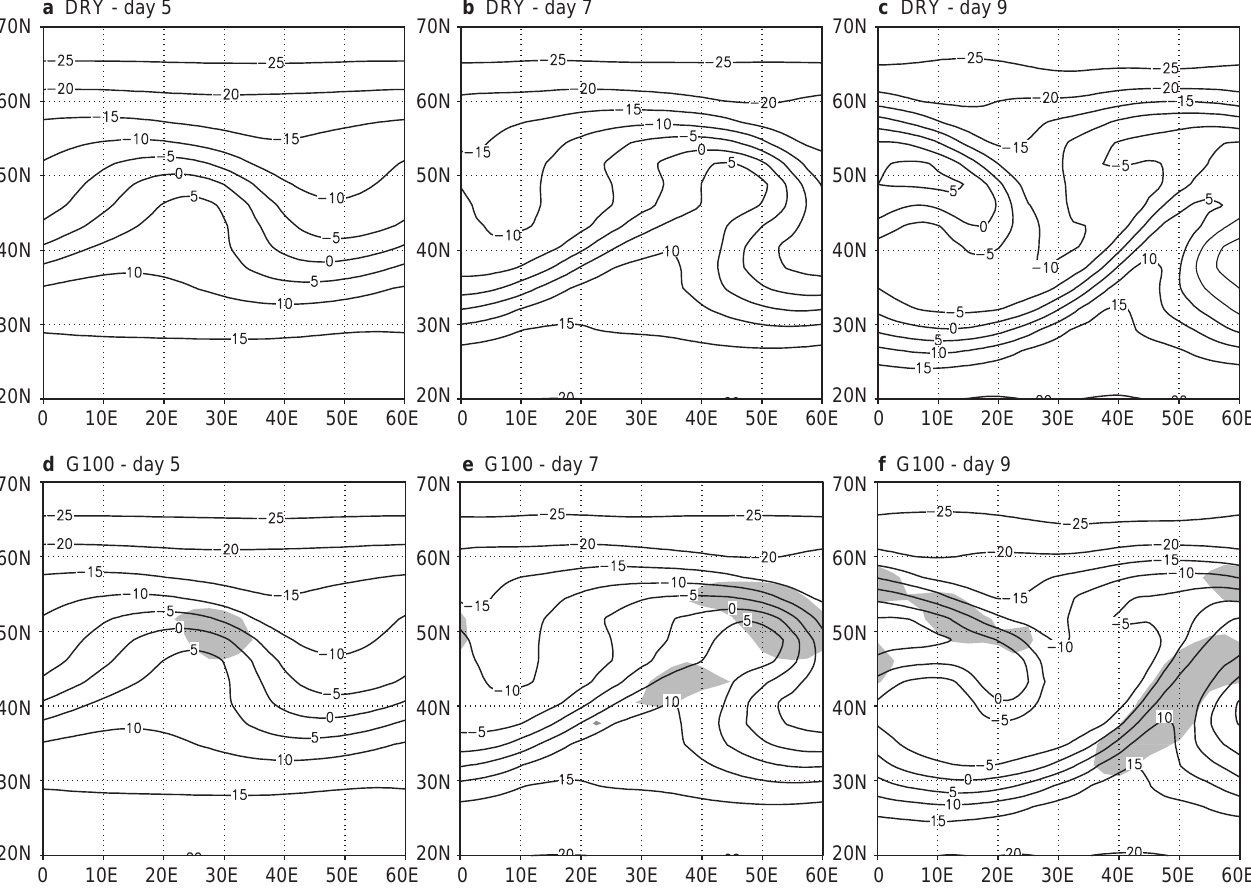
Fig. 4a–f. 965 mb temperature on days 5, 7 and 9 for the DRY experiment ( a, b, c ) and the G100 experiment ( d, e, f ). Contours every 5 (cid:14) C. Shading on G 100 denotes areas where the daily mean diabatic heating at this level is greater than 0.5